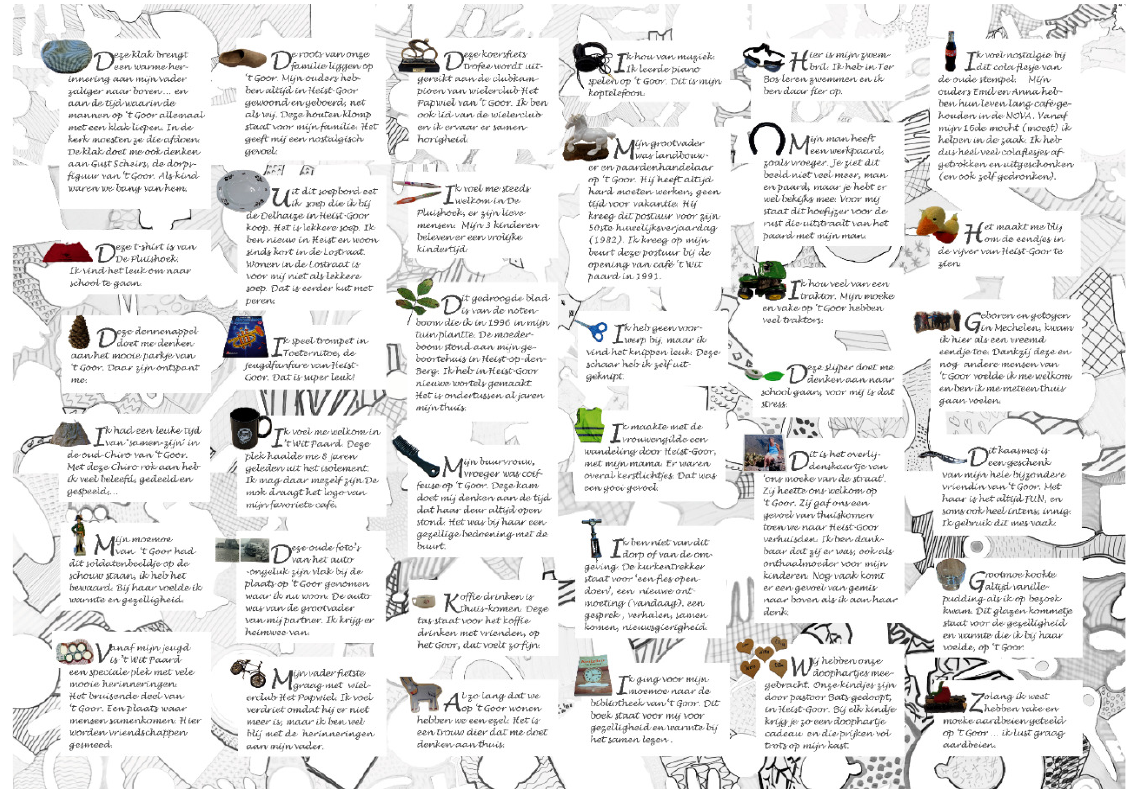
Figure 2. A compilation of object‐related memories, showing participants’ attachment to Heist‐Goor. Source: Ruth